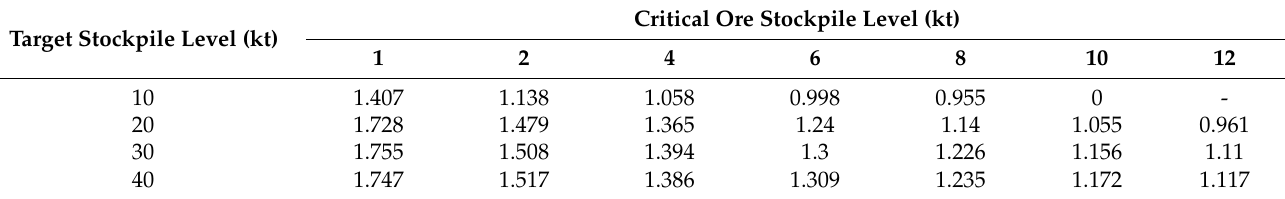
Table 6. Summary proportion of the time spent in Mode A vs. Mode B for each